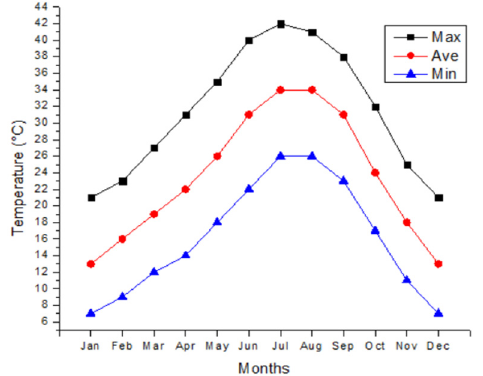
Figure 4. Maximum, average, and minimum local temperature of Mexicali during the season of harvest and operation of the GHP.